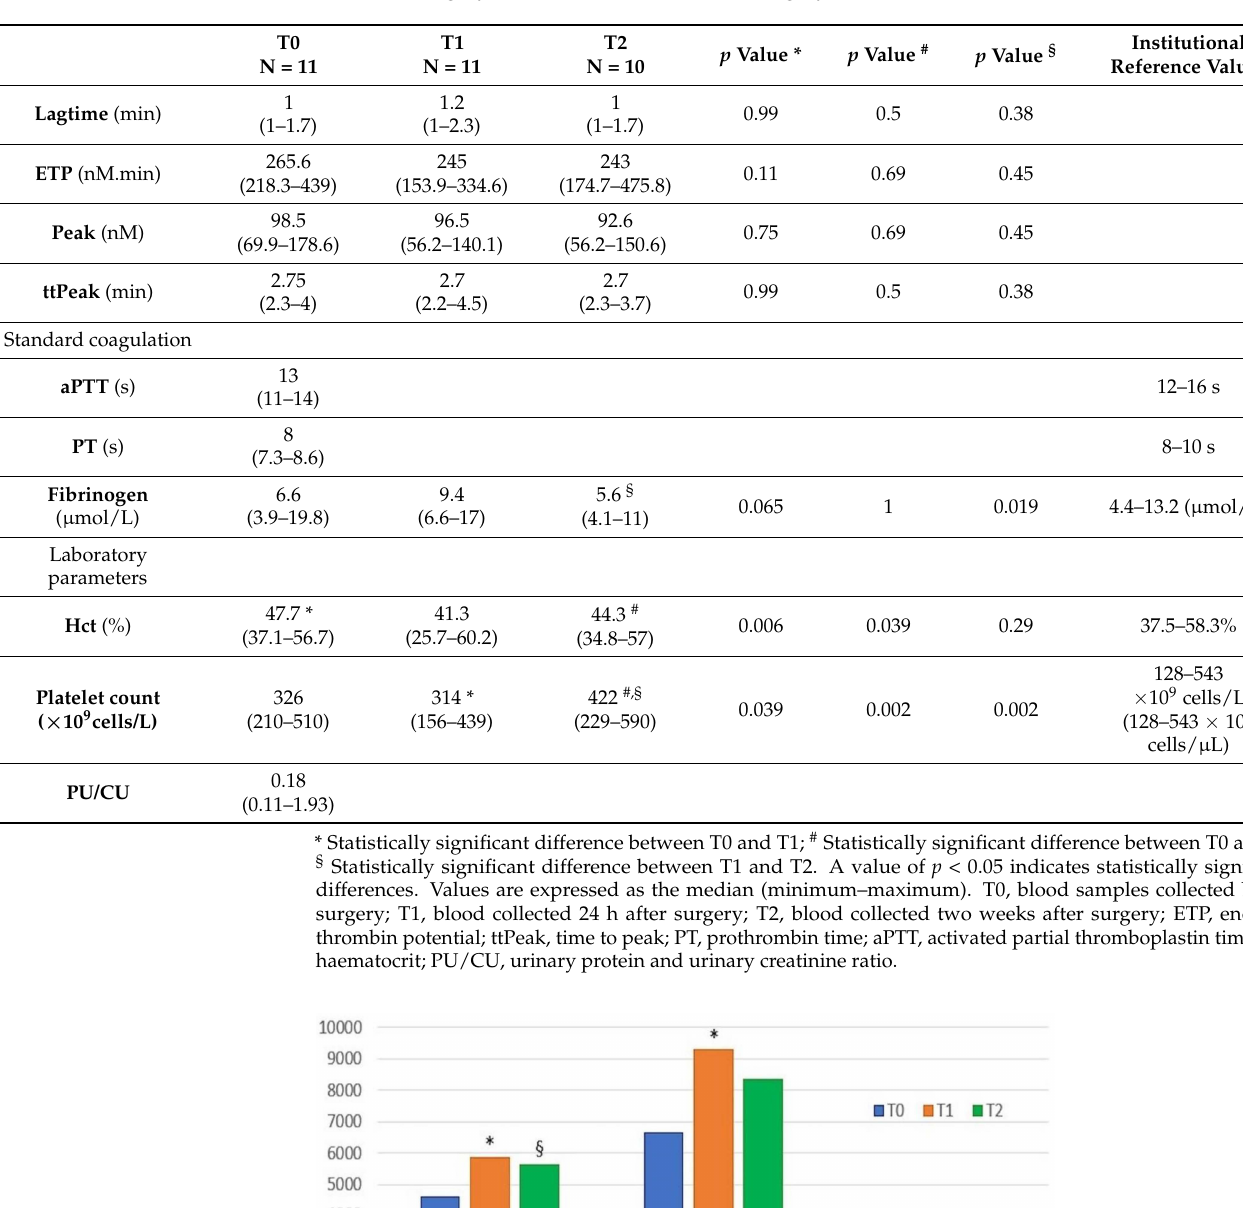
Table 2. Haemostasis assessment and laboratory parameters of interest assessed before surgery (T0), 24 h after surgery (T1), and two weeks after surgery (T2).